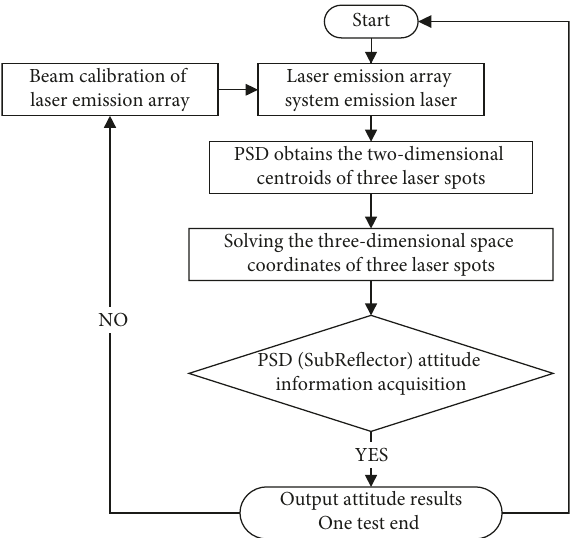
Figure 7: Test workflow of the laser measurement